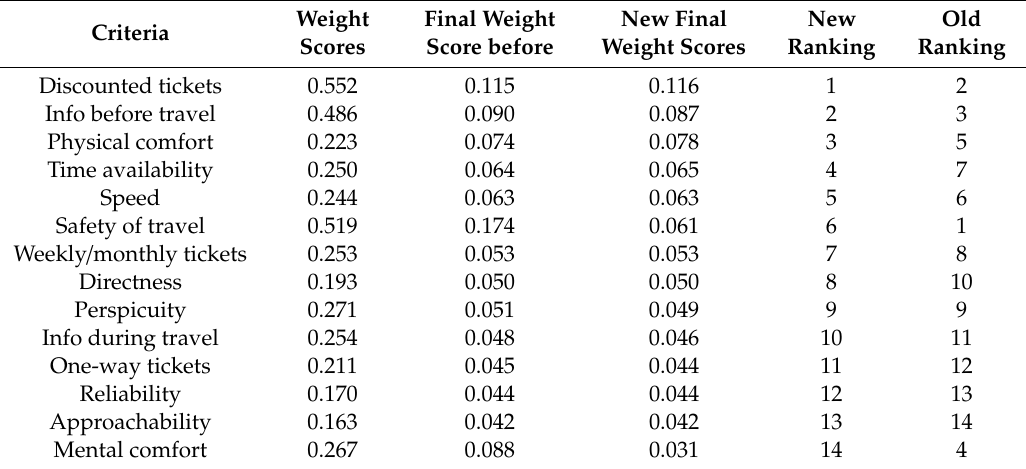
Table 8. Weight scores and ranking after the sensitivity check for level 2.